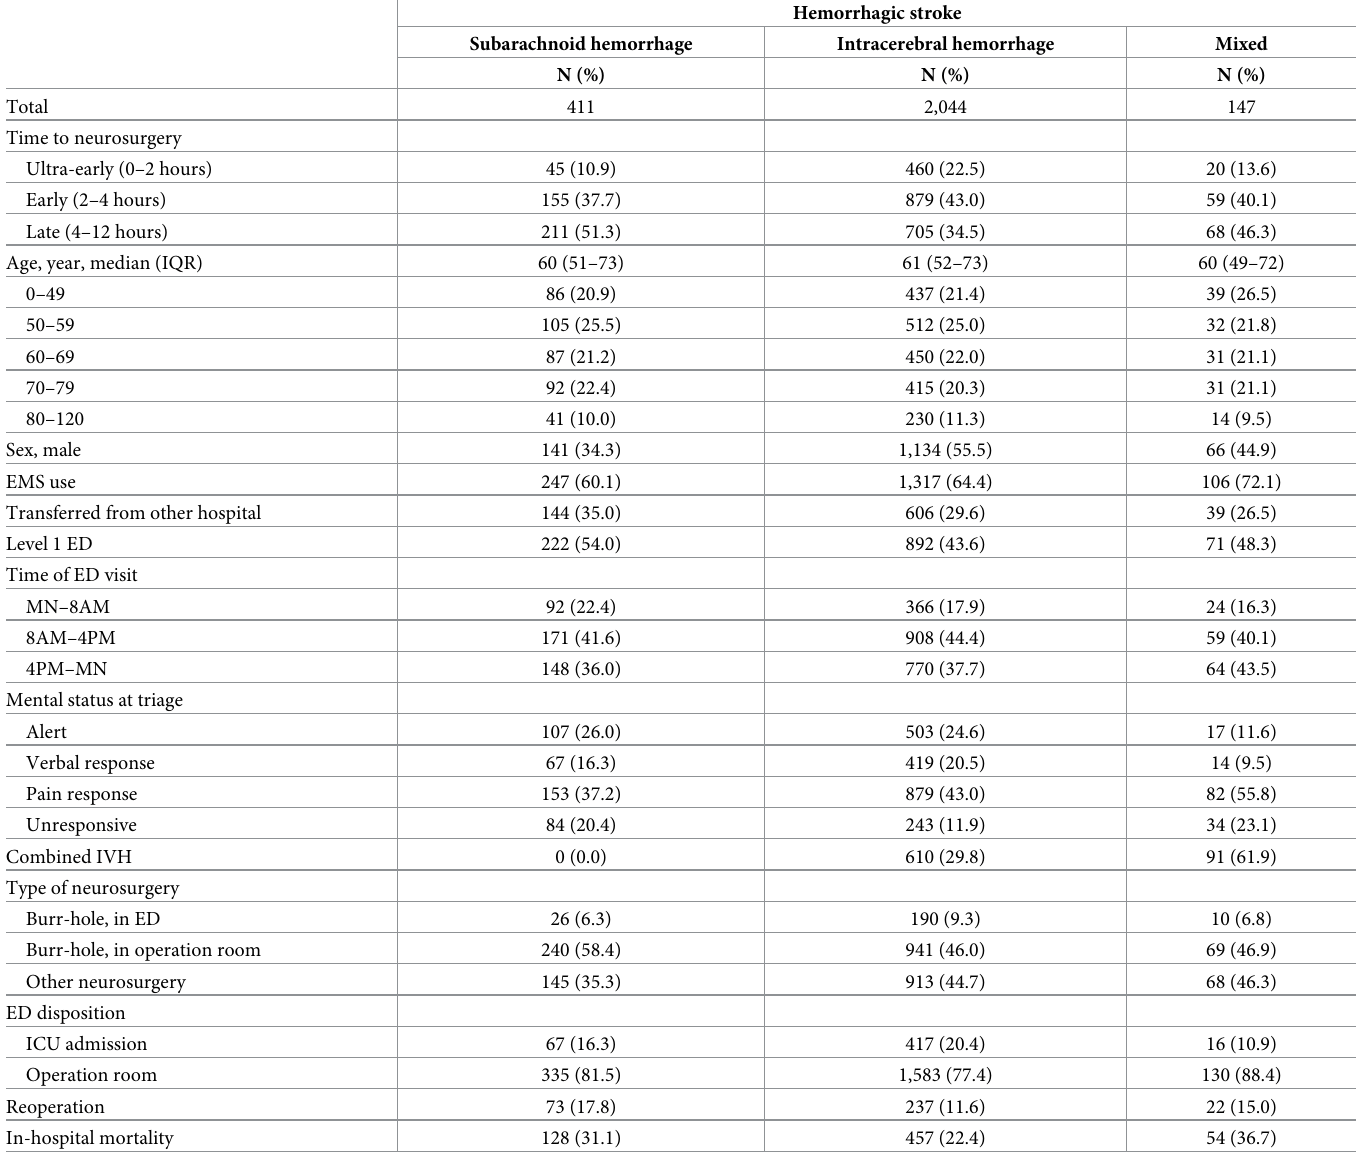
Table 2. Demographics of study population by subtype of spontaneous hemorrhagic